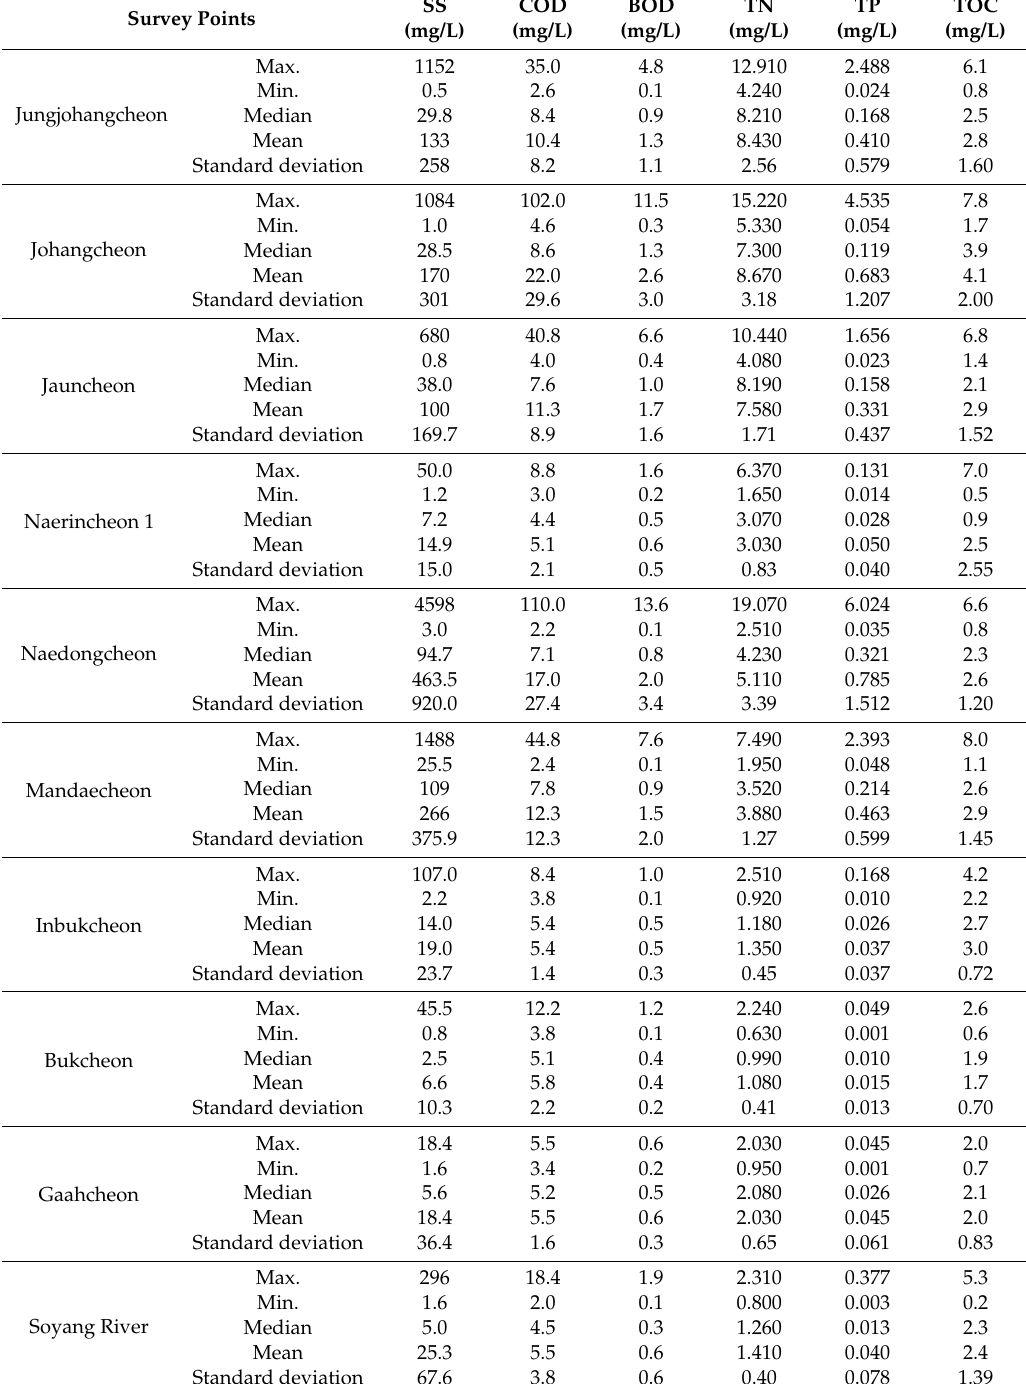
Table 4. Stormwater runoff water quality in the Lake Soyang watershed. Survey